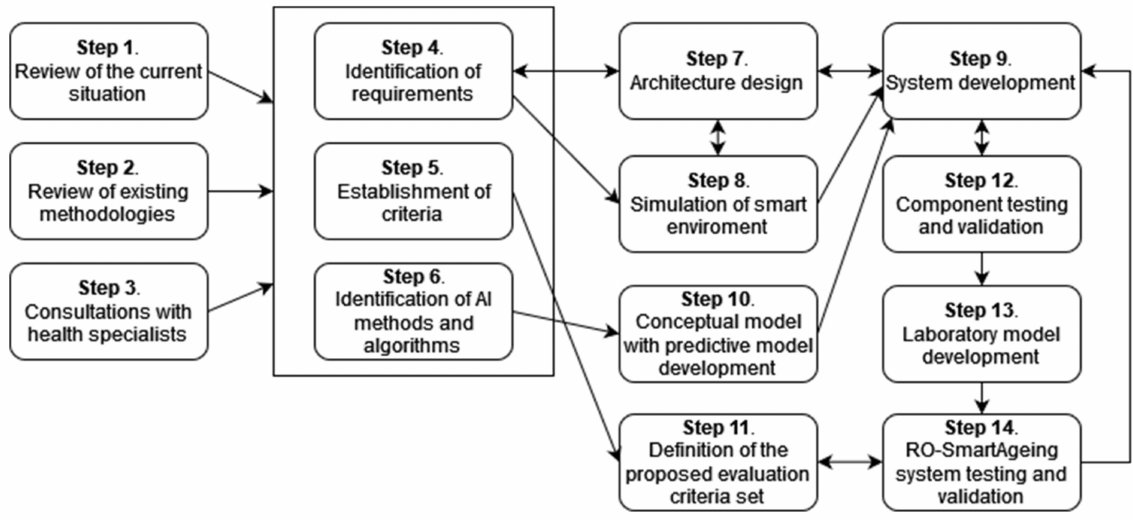
Figure 1. Steps for implementing the RO-SmartAgeing